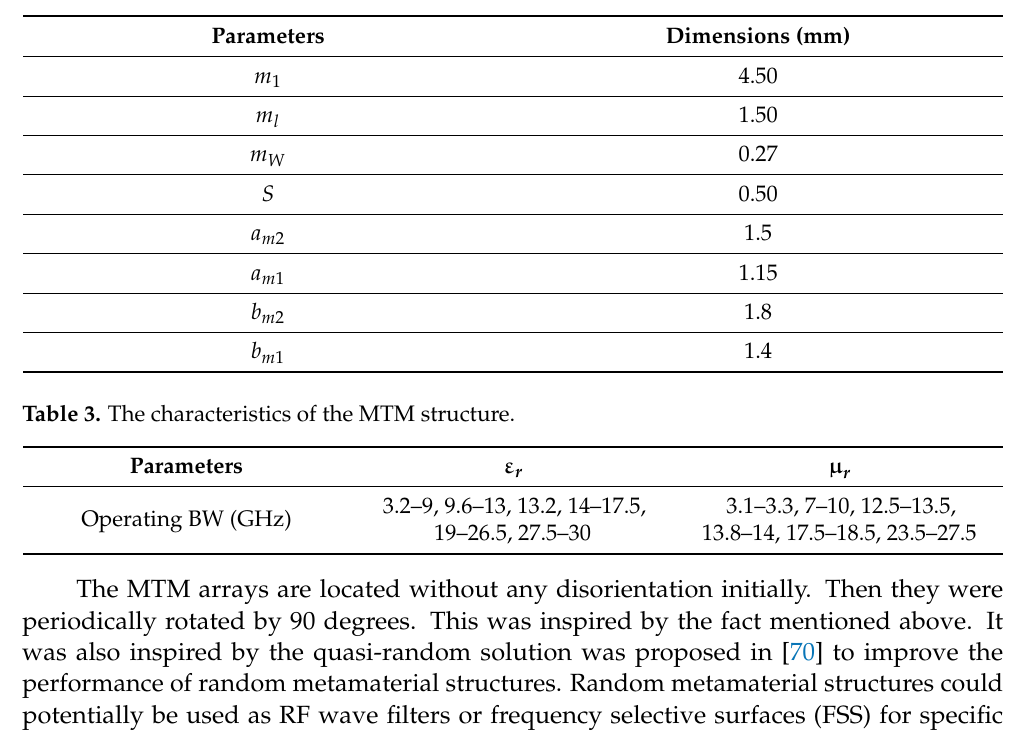
Table 2. MTM structure dimensions.